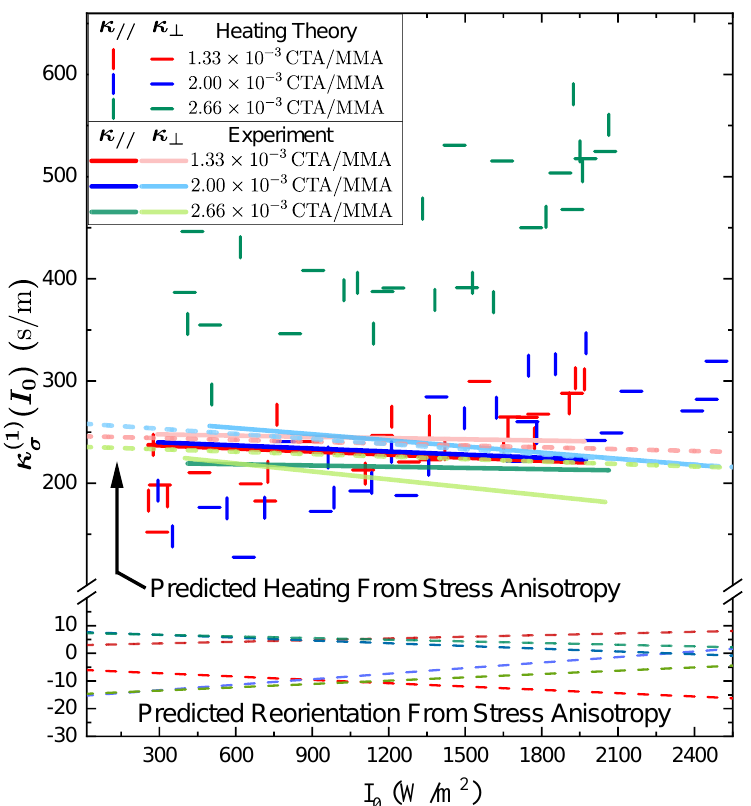
Figure 17. The vertical and horizontal lines (representing the pump polarization relative to the vertical) show the predicted heating contribution to the photomechanical response as a function of intensity using the theory (Equation (7)) and the parameters determined from the fits in Figure 9 of the temperature-induced stress. The smooth lines show the experimentally determined intensity- dependent photomechanical constant determined by the fit of the data to a quadratic function in the intensity, as shown in Figure 11, and identical to the results shown in Figure 12, but, here the points ( re ) ( I ) , and κ ( re ) ( I ) are also plotted and determined are connected to make smooth curves. κ ( heat ) ( I ) , κ ⊥ // from the tensor properties of the polarization-depended response using Equations